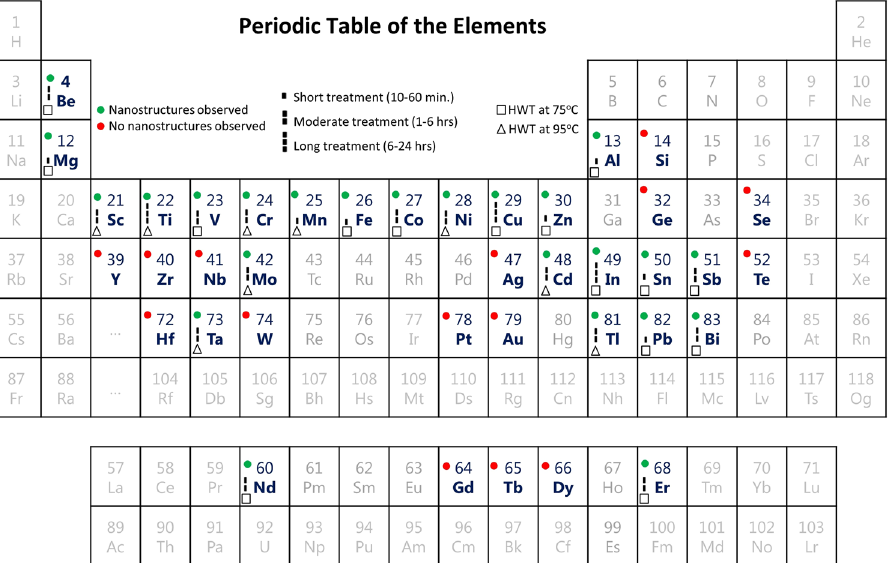
Figure 3. Periodic table of elements showing the elemental metals included in this study (bold blue font) and their response to HWT time and temperature. Green solid circles refer to the metals which responded to the HWT process and MONSTRs were observed; while red solid circles correspond to the metals that did not shows any sign of MONSTR formation. Treatment temperatures are represented by square shapes for HWT treatment at 75 °C and triangles shape for 95 °C. Treatment time is denoted by solid